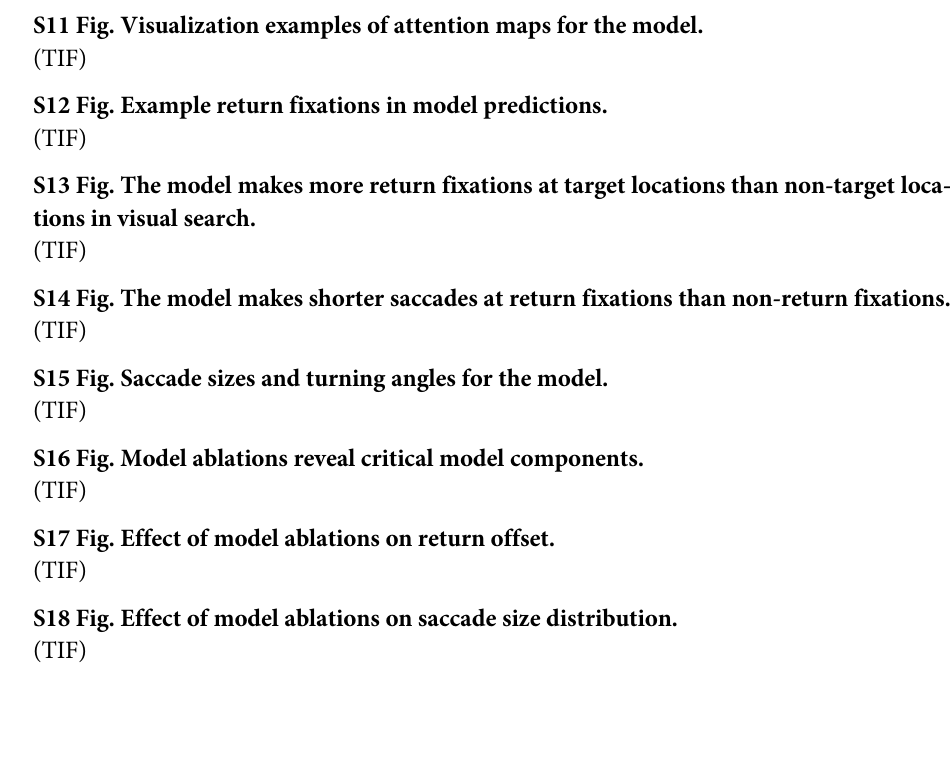
S1 Fig. Proportion of fixations that revisit the same location twice. (TIF) S2 Fig. Extraction of fixations on egocentric videos. (TIF) S3 Fig. Proportion of return fixations among the first six fixations. (TIF) S4 Fig. Return fixations are consistent across subjects. (TIF) S5 Fig. Example of return fixation consistency across subjects. (PDF) S6 Fig. Distribution of saccade sizes. (TIF) S7 Fig. Saccade sizes and angles for primates. (TIF) S8 Fig. Return and non-return fixation locations. (PDF) S9 Fig. Calculation of bottom-up saliency map, target similarity map, and recognition map in the computational model. (TIF) S10 Fig. Memory decay function and 2D empirical distribution of saccade sizes. (TIF) S11 Fig. Visualization examples of attention maps for the model. (TIF) S12 Fig. Example return fixations in model predictions. (TIF) S13 Fig. The model makes more return fixations at target locations than non-target loca- tions in visual search. (TIF) S14 Fig. The model makes shorter saccades at return fixations than non-return fixations. (TIF) S15 Fig. Saccade sizes and turning angles for the model. (TIF) S16 Fig. Model ablations reveal critical model components. (TIF) S17 Fig. Effect of model ablations on return offset. S18 Fig. Effect of model ablations on saccade size